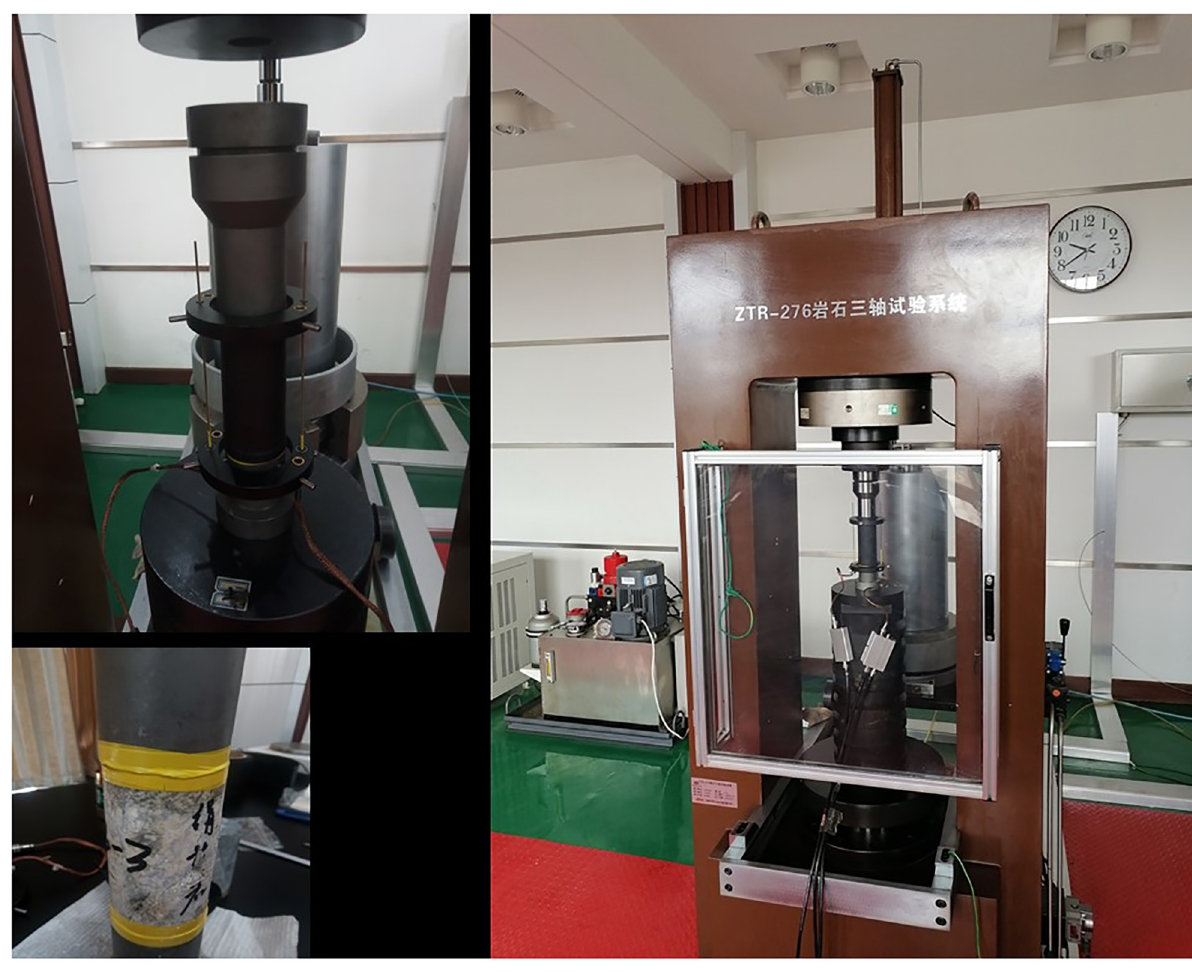
Fig 13. ZTR-276 rock triaxial test